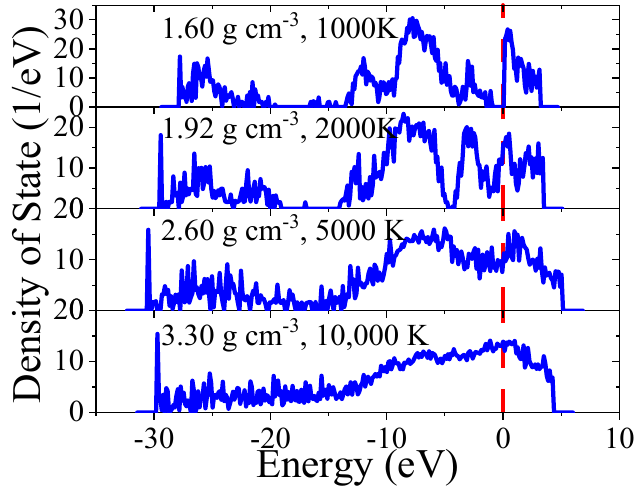
Figure 11. Electric density of states of warm dense nitric oxide at different densities and temperatures using PBE functional. The Fermi level is shown as the red dashed line.